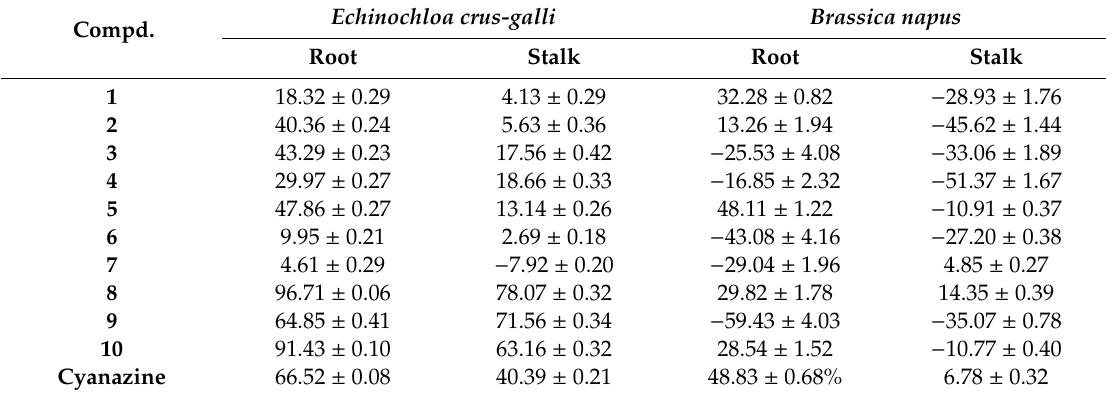
Table 3. Inhibitory ratio of 10 compounds against Echinochloa crus-galli and Brassica napus (Inhibitory ratio ± SD, %). Echinochloa crus-galli Brassica napus Compd.